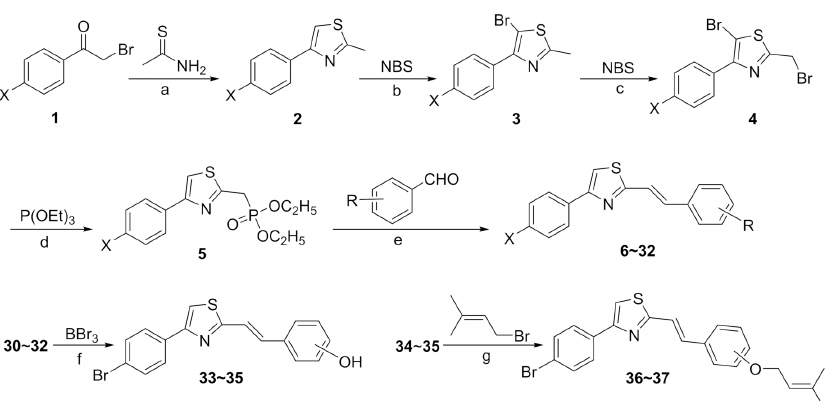
Scheme 1. The synthesis of target compounds 6 ~ 37 . Reagents and conditions: ( a ) DMF, r.t., 5 h; ( b ) ethyl acetate, reflux, 3 h; ( c ) CH 3 CN, r.t., 4 h, 15 W LED; ( d ) reflux, 4 h; ( e ) NaOH, DMF, r.t., 5 h;